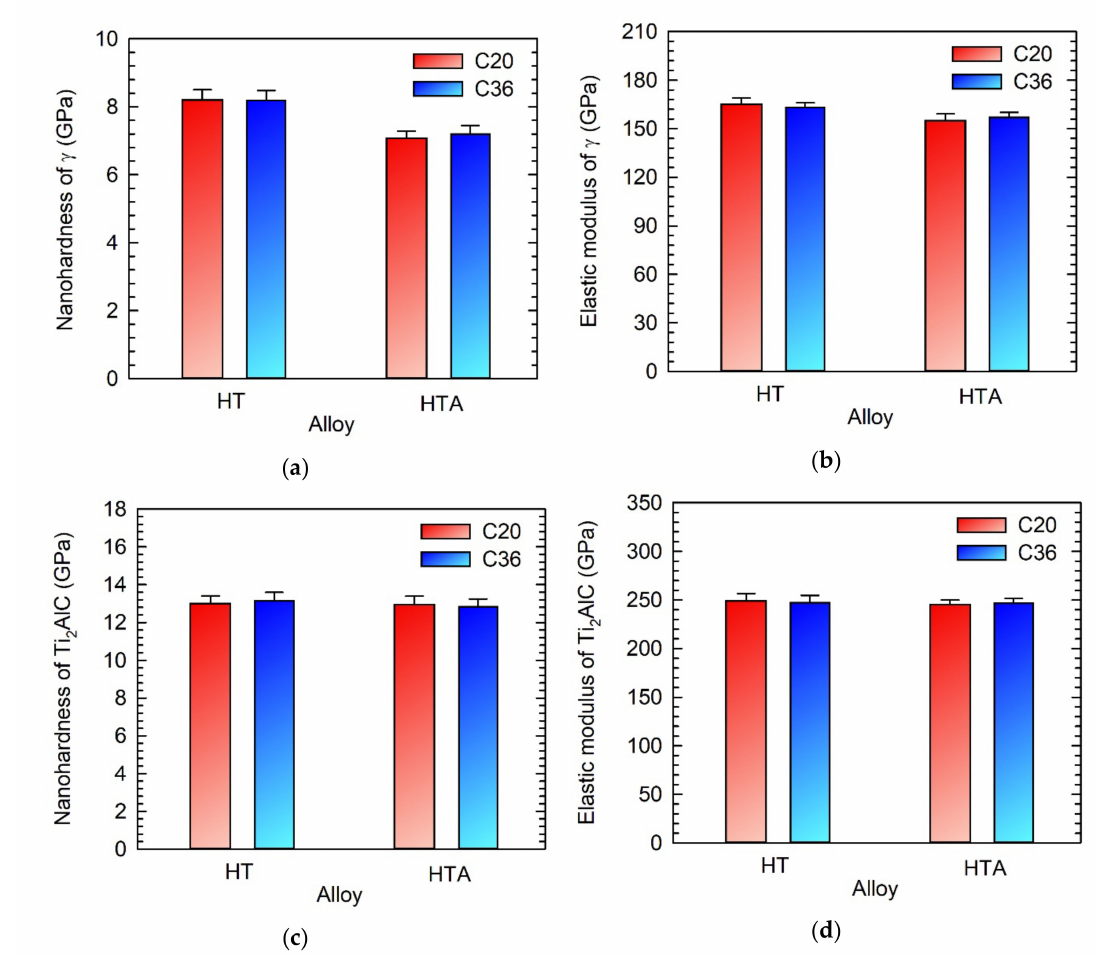
Figure 8. Indentation nanonahardness and elastic modulus of C20 and C36 alloys after heat treatment and heat treatment combined with ageing: ( a ) Indentation nanohardness of grain boundary γ phase; ( b ) Indentation elastic modulus of grain boundary γ phase; ( c ) Indentation nanohardness of primary Ti 2 AlC particles; ( d ) Indentation elastic modulus of primary Ti 2 AlC particles. The type of alloys and applied treatments are marked in the